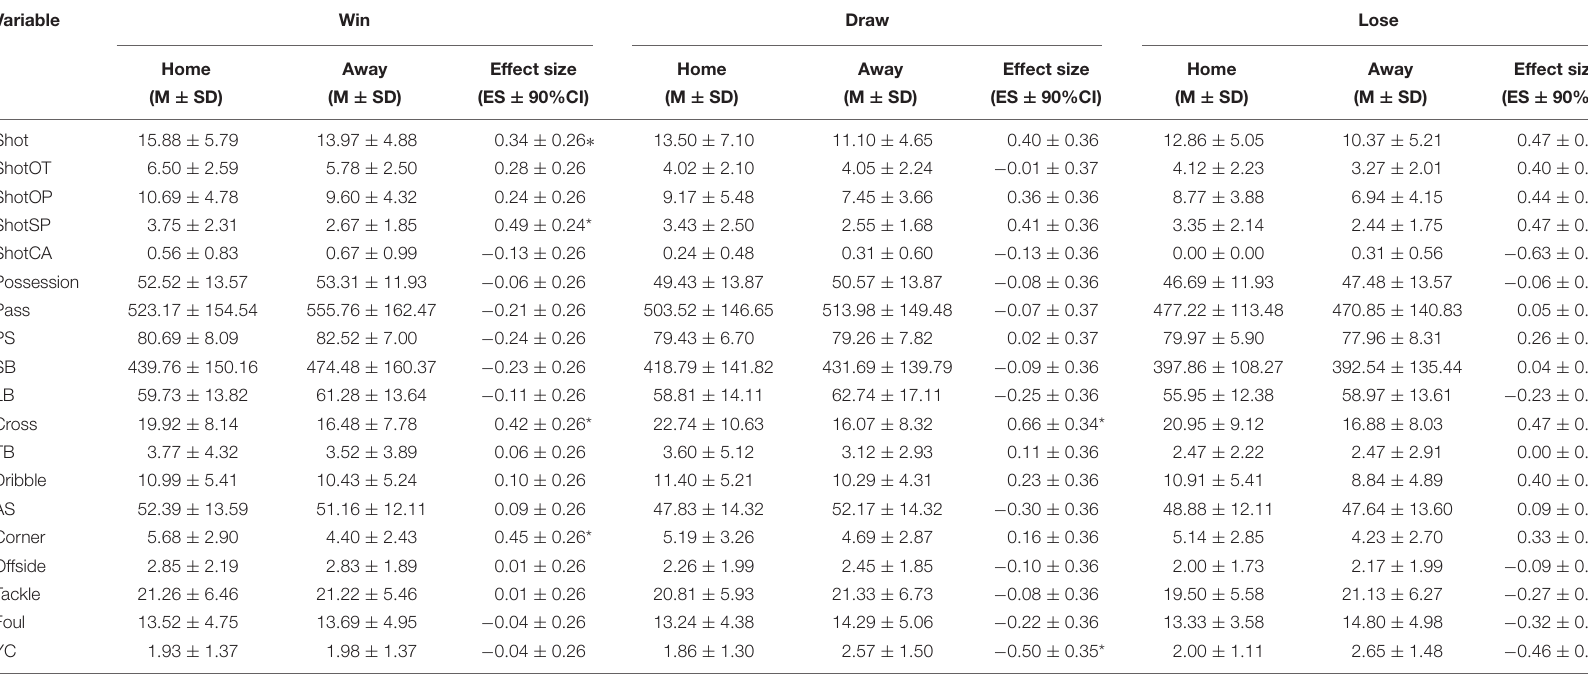
Descriptive statistics of teams in Tables 2 – 5 are presented as mean ± standard deviation (M ± SD). Effect sizes (ES) are presented as the magnitude of the true difference in means ± 90% confidence interval. Asterisks indicate that the p-value is lower than the significance level of 0.05. ShotOT, shot on target; ShotOP, shot from open play; ShotSP, shot from set piece; ShotCA, shot from counter-attack; PS, pass success; SB,